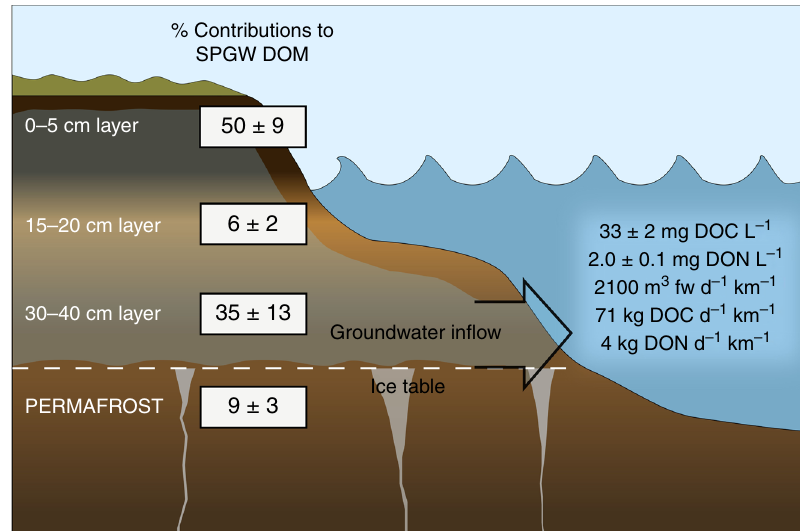
Fig. 2 Schematic of SPGW fl ow to Arctic coastal lagoons during late summer summarizing several key results of this study. (left) Estimates of the percent contributions of soil-DOM from active layer and thawing permafrost soils to SPGW DOM. Percent soil-DOM contributions were made by multiplying soil-DOC yield values of the four indicated soil sections by their horizon thickness and then divided by the sum of the adjusted soil-DOC yields. (right) Average concentrations of DOC and DON found in SPGW and maximum freshwater, DOC, and DON fl ux values calculated from 222 Rn measurements. Values in the schematic are ±1 standard